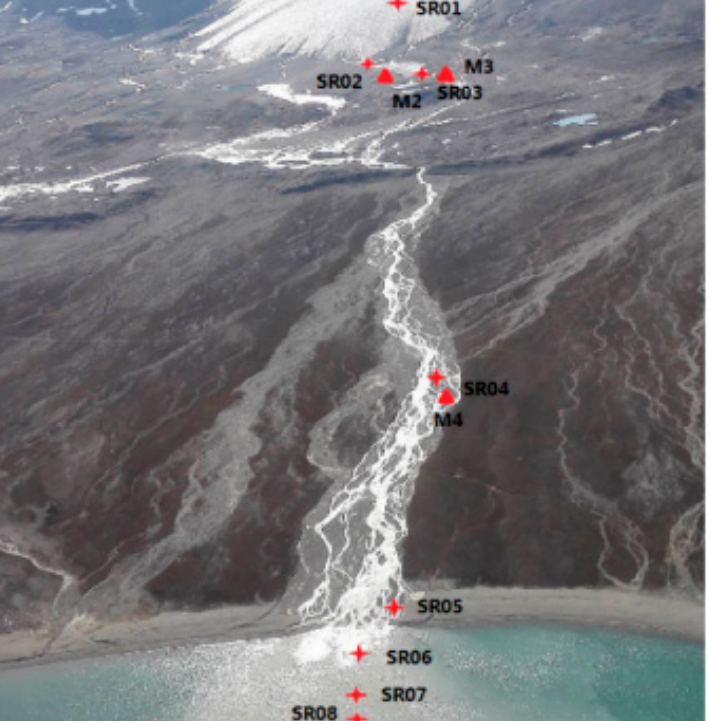
Figure 2. Sampling sites in Ny-Ålesund, Svalbard, Red symbols present sampling sites.